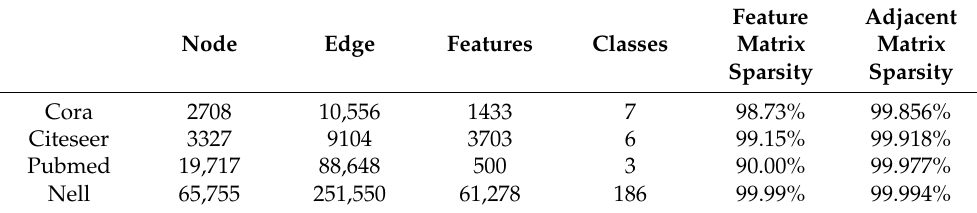
Table 1. Sparsity differences of Cora, Citeseer, Pubmed, and Nell